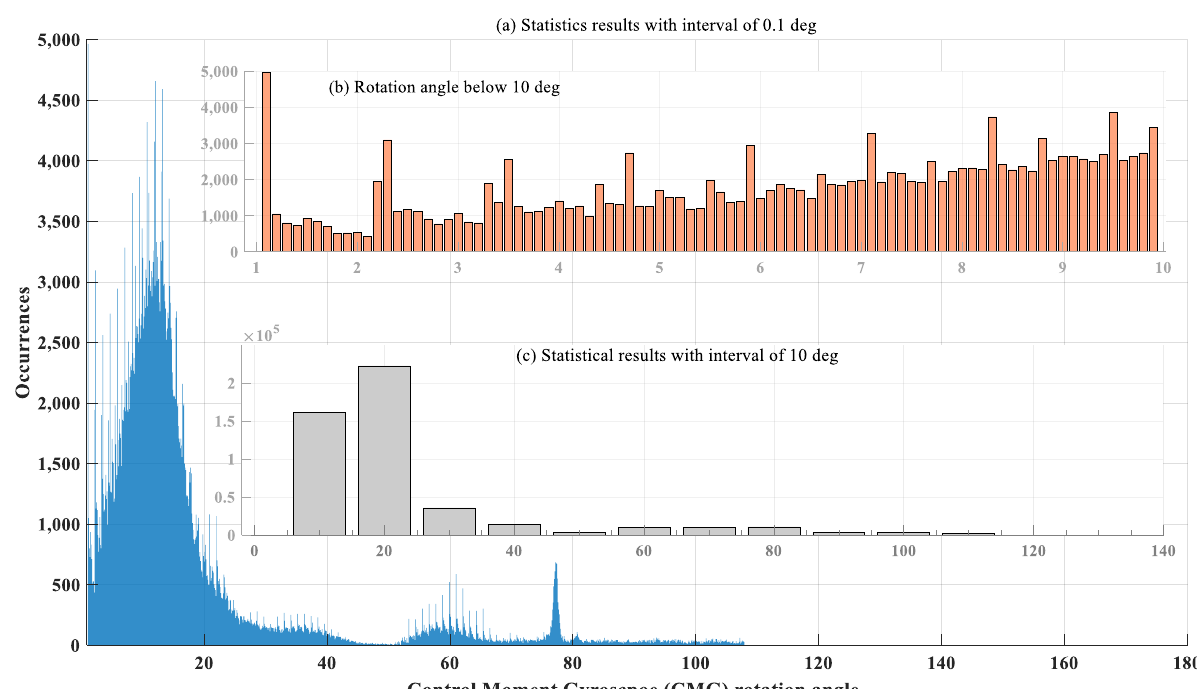
Figure 6. CMG rotation angle statistics results. ( a ) Represents the main graph with an angular statistic interval of 0.1 ◦ . ( b ) A zoomed-in display of rotation angles below 10 ◦ . ( c ) Counts the statistics at 10 ◦